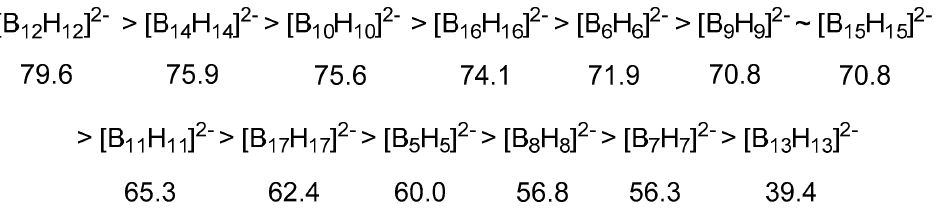
Figure 4. HDA MeCN of polyhedral closo -borane dianions [B n H n ] 2 − (n = 5–17). Blue columns represent the lowest HDA MeCN values, and red columns represent the highest in the given anion; green columns show HDA MeCN for symmetric [B 6 H 6 ] 2 − and [B 12 H 12 ] 2 − dianions.